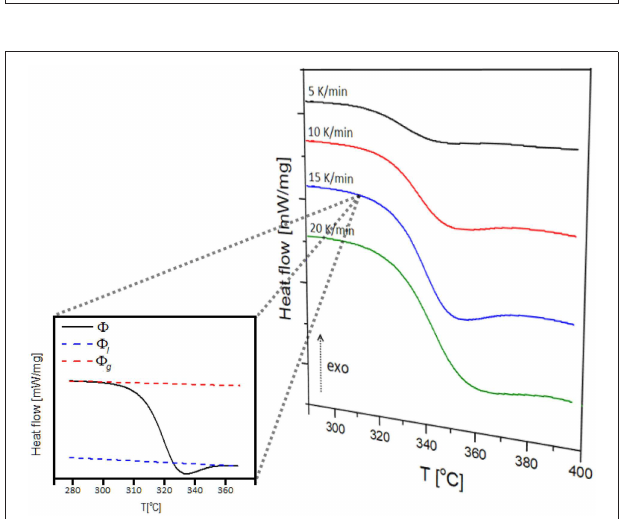
FIGURE 9 | Multiple heating rate DSC curves of 80NaPO 3 – 20AlF 3 glass and determination of the extent of conversion at the heating rate of 15 K/min.